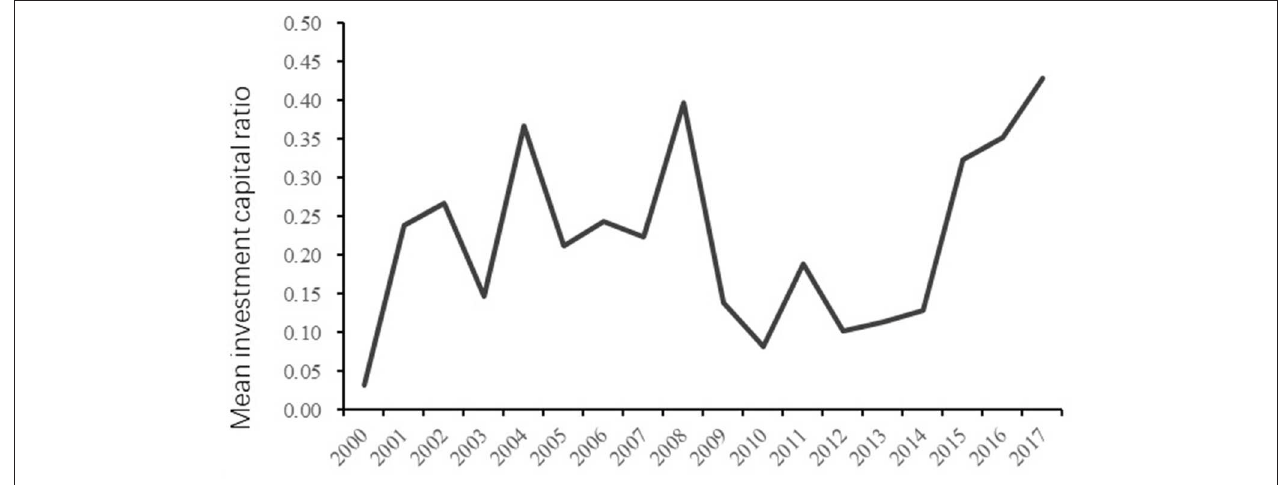
FIGURE 3 | Trend of corporate investment (annual average scaled by capital stock, I/K).